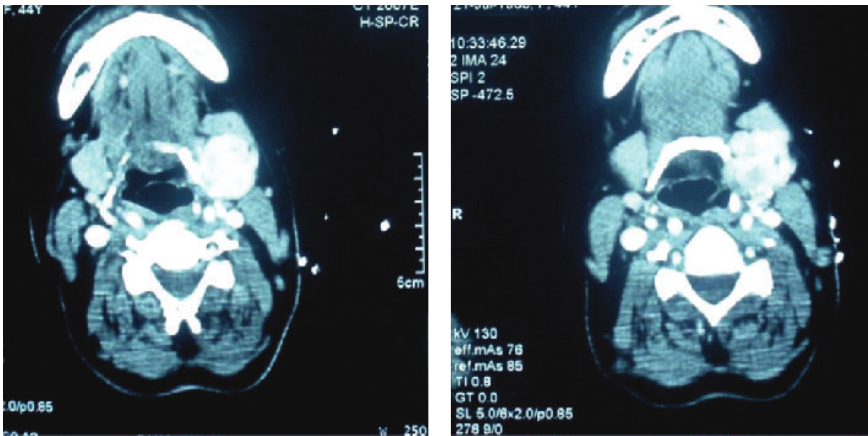
Figure 2: Postcontrast computed tomography findings; a well-circumscribed left submandibular